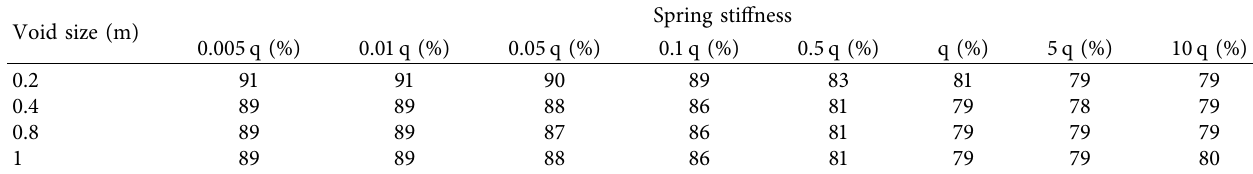
Spring stiffness